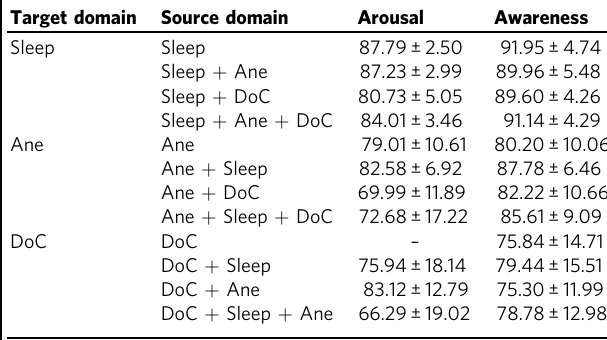
Table 2 Averaged single-trial classi fi cation accuracy (%) in physiological, pharmacological, and pathological conditions for TMS – EEG: this represents the accuracy ± standard